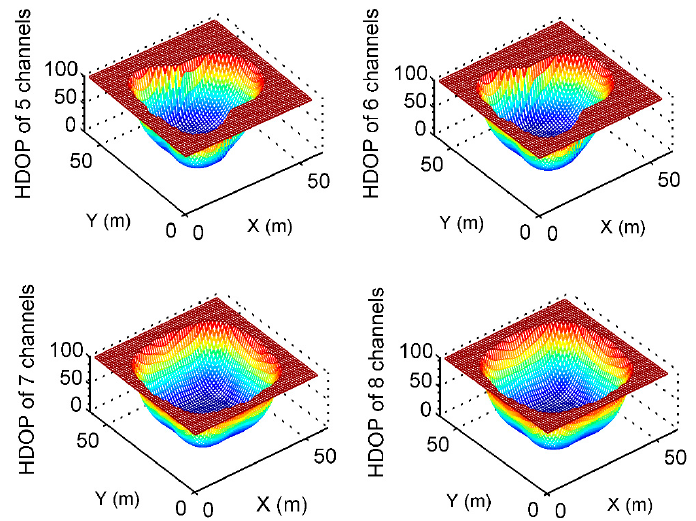
Figure 12. HDOP using Doppler positioning algorithm from 5 to 8 channels. Table 7. Number of grids for HDOP with the di ff erent number of transmitting Channels. HDOP <